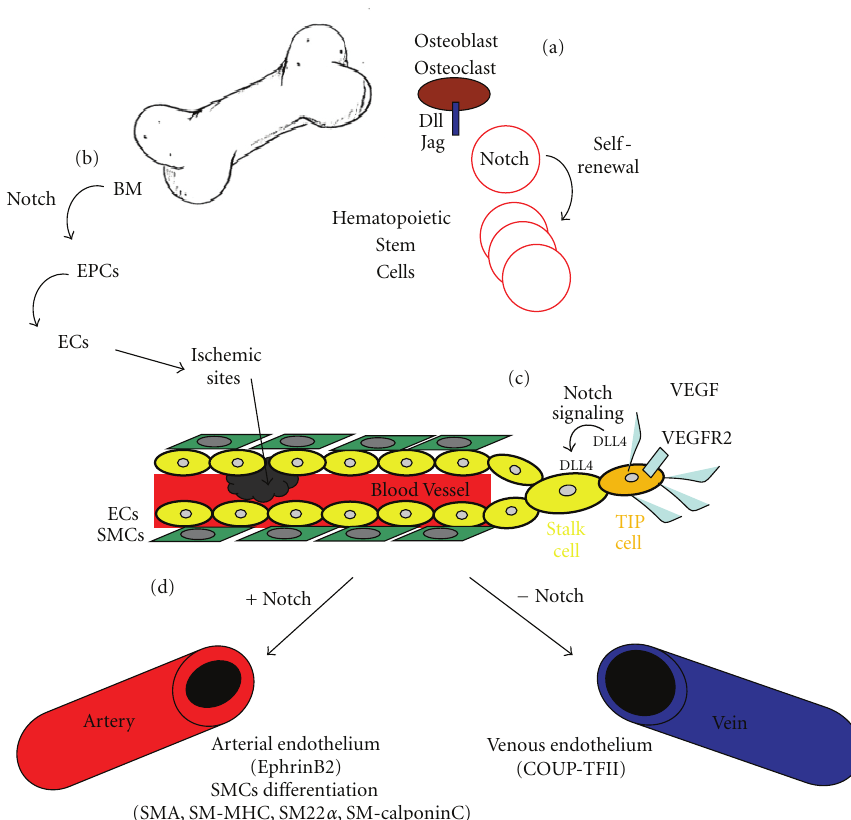
Figure 2: Scheme showing the essential functions of Notch in blood and vascular cell types (a) Osteocyte Dll/Jag-induced Notch signaling in hematopoietic stem cells (HSCs) is involved in their generation and self-renewal in the adult. (b) Notch signaling pathway is required for endothelial progenitor cells (EPCs) development and function. EPCs from bone marrow niches will, in response to Notch, di ff erentiate in endothelial cells (ECs) and populate sites of ischemia participating in vascularization. (c) Schematic representation of a growing blood vessel. In angiogenesis, Notch ligand DLL4 is upregulated in response to VEGF/VEGFR2 signaling in tip cells, that are specified ECs (dark yellow) capable of sprouting by extending filopodia. Upregulated DLL4 in tip cells activates Notch in the neighbor stalk ECs (light yellow) inhibiting their sprouting capacity. Notch activation in stalk cells will result in further DLL4 upregulation, which eventually will activate Notch in adjacent cells. SMCs, covering the endothelium are represented in green. (d) Notch induces arterial specification of ECs by upregulating the expression of arterial markers, such as EphrinB2. The lack of Notch in venous endothelial cells allows the expression of venous markers, such as COUP-TFII. Notch regulates also smooth muscle cell (SMC) di ff erentiation by inducing the expression of SMC-specific markers (e.g., α SMA, SM-MHC, SM α 22, and SM